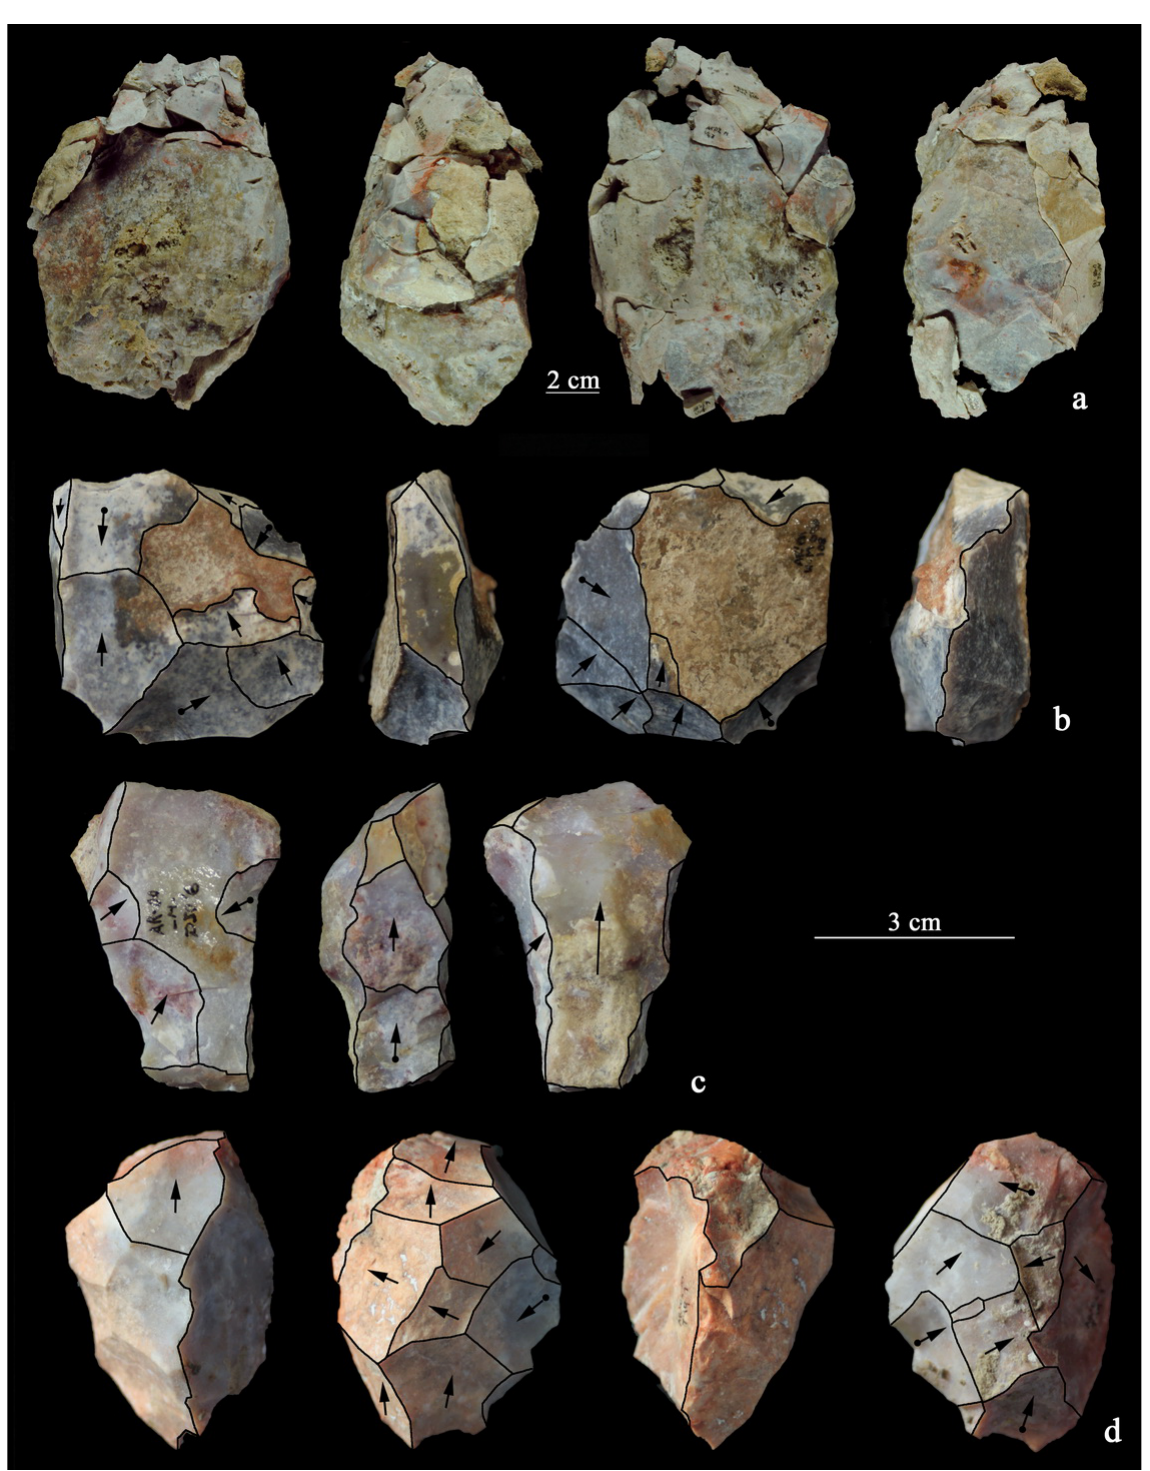
Figure 7. Layer M. (a): refit. Scale bar 2 cm. (b): discoidal unifacial core; (c): core-on-flake; (d): diacoidal bifacial core. Scale bar 3